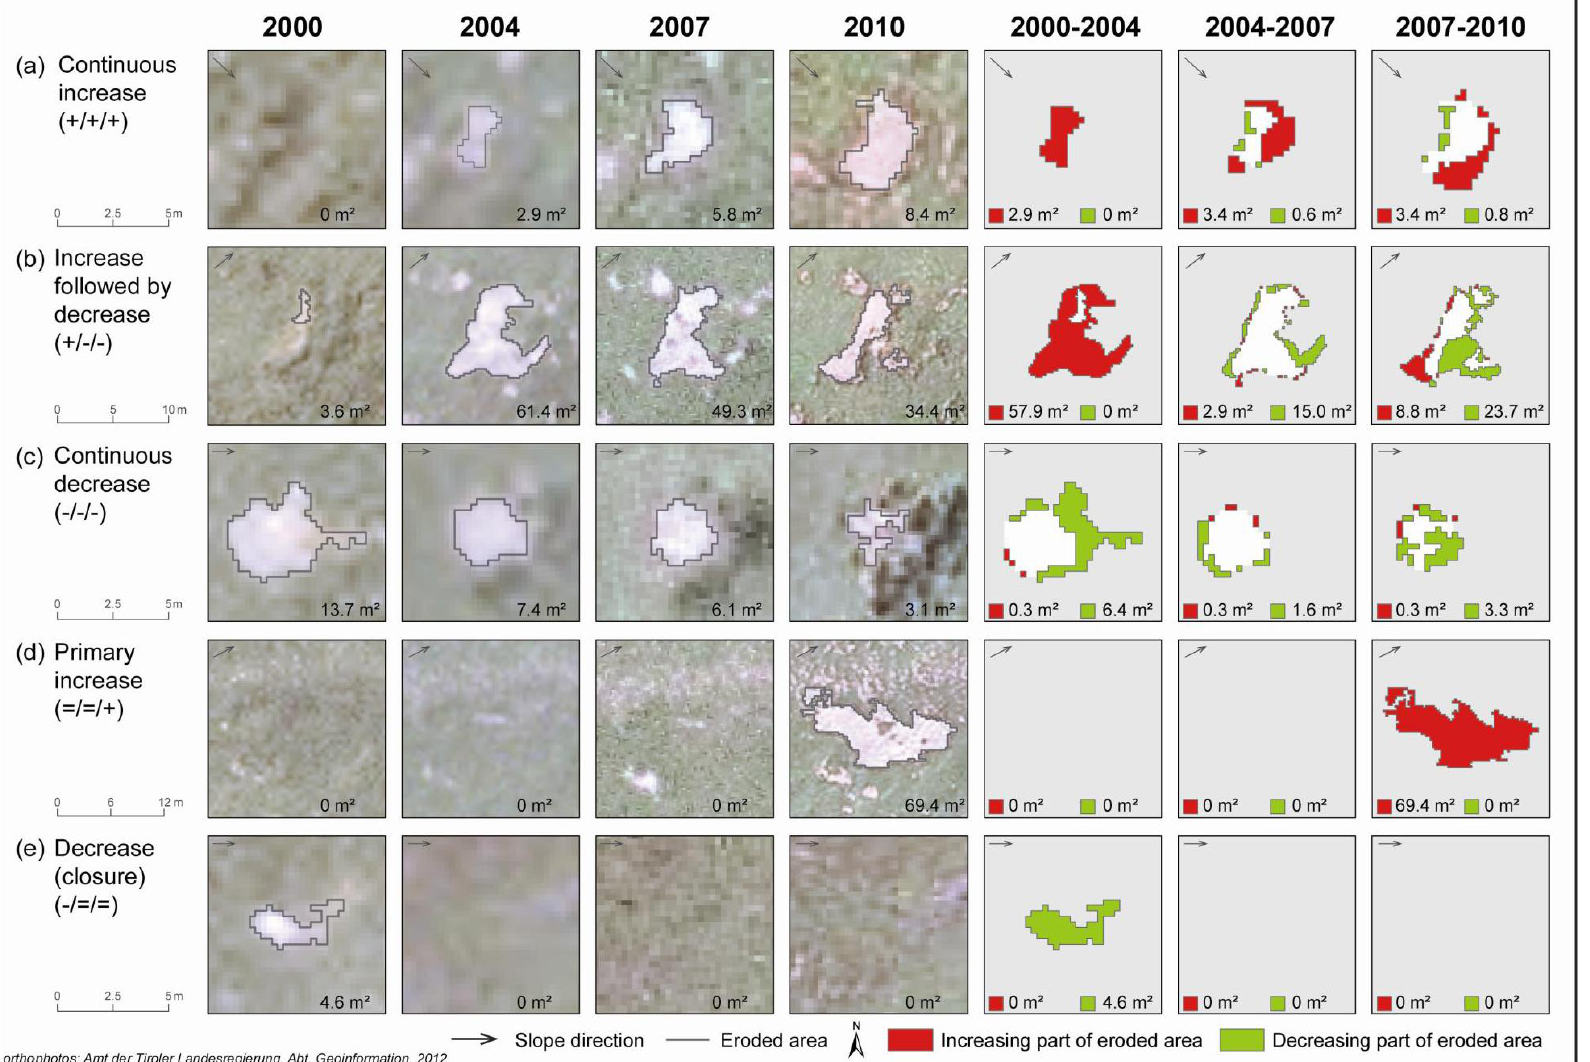
Figure 8. Example areas for the determination of quantitative changes at plot